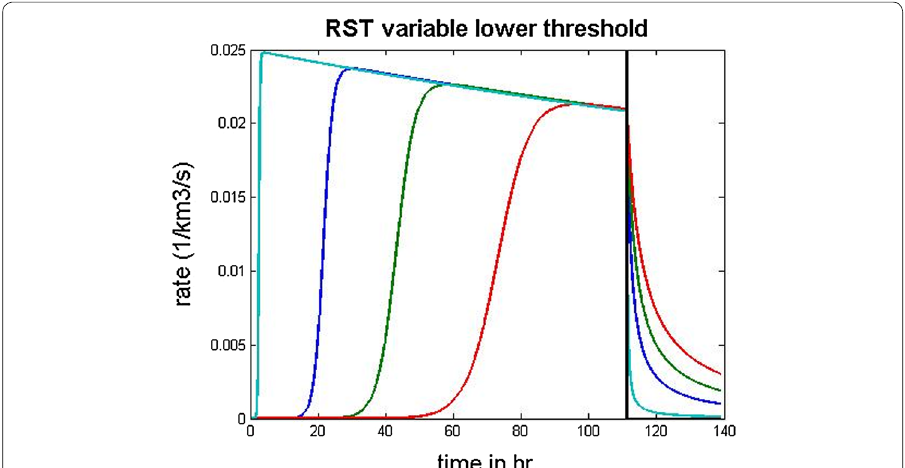
Fig. 4 Comparison between the CPT and RST seismicity density for a linear pressure ramp up to 10 MPa at 111 h followed by a sudden drop of pressure rate to zero. CPT provides the constant seismicity of 0.025 1/ km 3 /s until 111 h followed by a sudden drop to zero. RST depends very much on the lower threshold values C RST : 6, 50, 100, 170 kPa with time delays increasing with C RST during the time of pressure growth. After pres- sure rate drops to zero, RST seismicity falls off with a time constant again growing with C